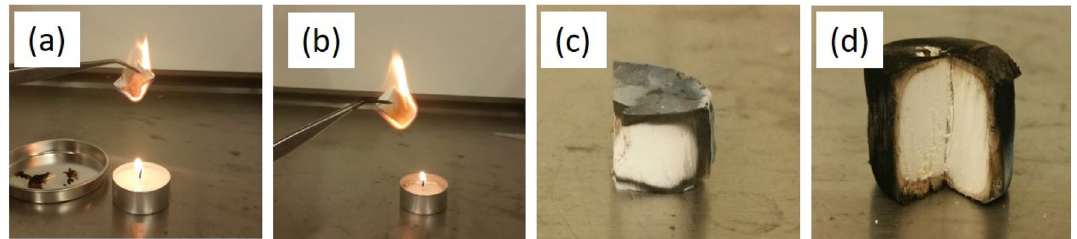
Figure 6. Results of the fire behavior tests of the freeze casts. ( a ) Sample 10-0 burns off completely. ( b ) The sample 10–0.5 MFC also burns off completely. ( c ) Sample 10-10-SiO 2 after about one minute flame exposure. ( d ) Sample 10–5 NC after one minute of flame